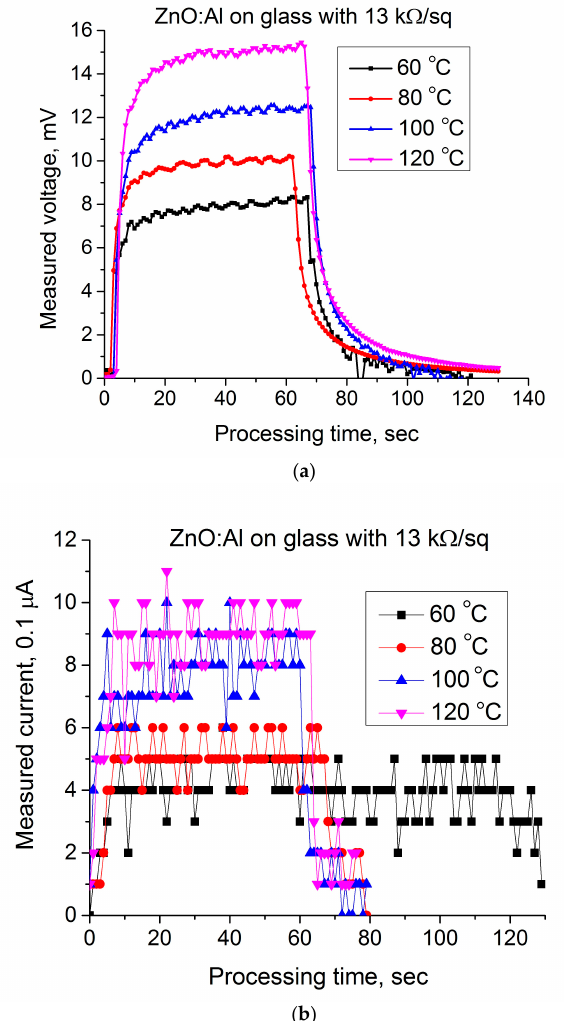
Figure 6. Dynamic hot-probe characteristics of the high-resistive AZO coatings: ( a ) a voltage meas- ured between hot and cold electrodes; ( b ) a current between electrodes.